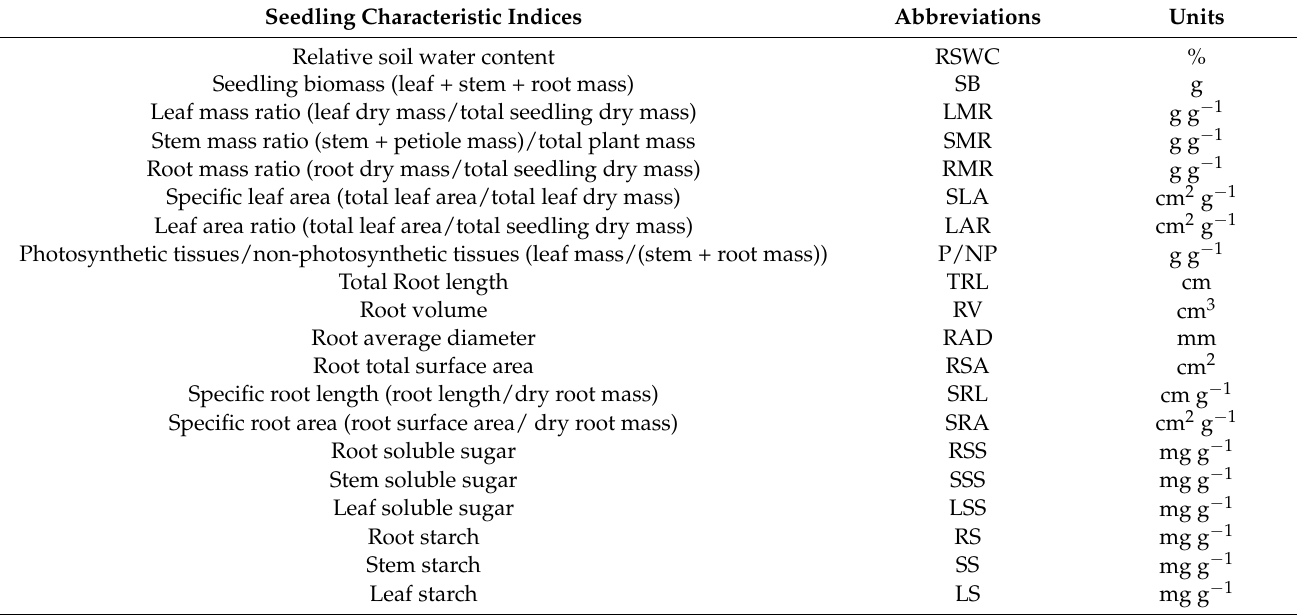
Table 1. Seedling characteristic indices, abbreviations, and